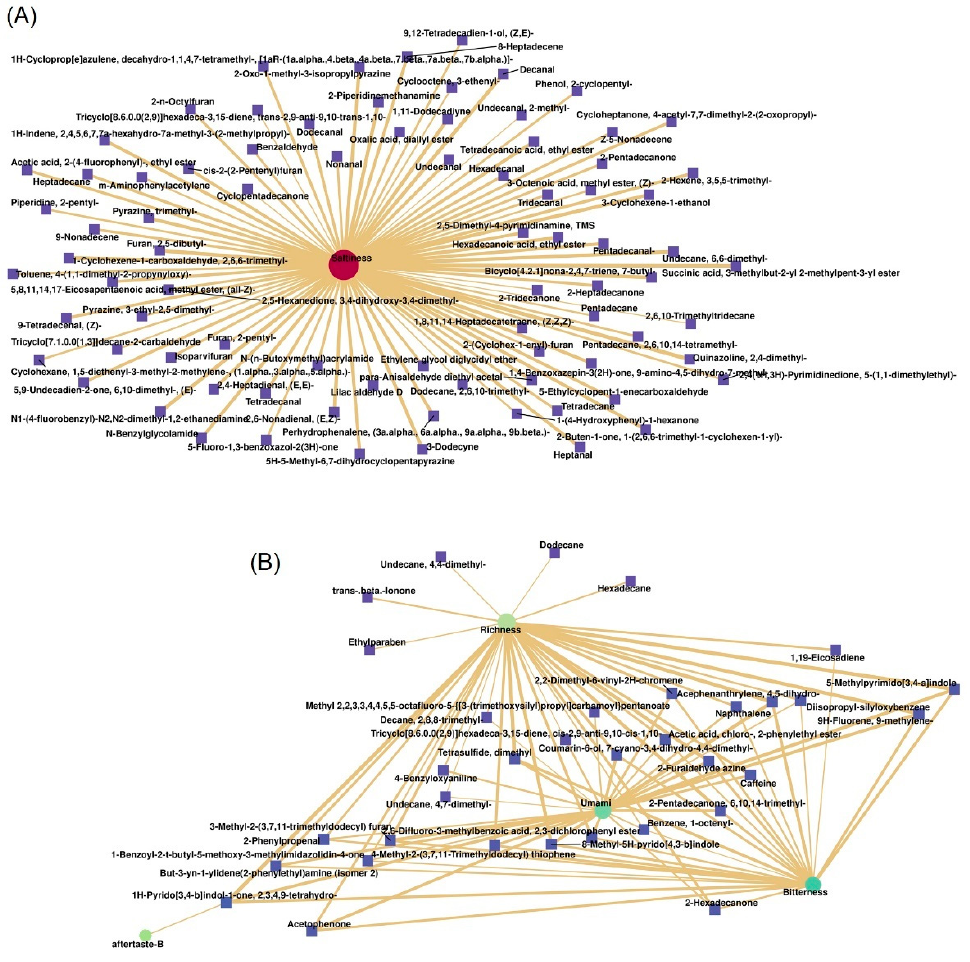
Figure 8. Correlation network between saltness ( A ) and richness, umami, aftertaste-B and bitterness ( B ) wiht the VOCs in shrimp paste samples fermented for 1, 2, 3, and 8 years.